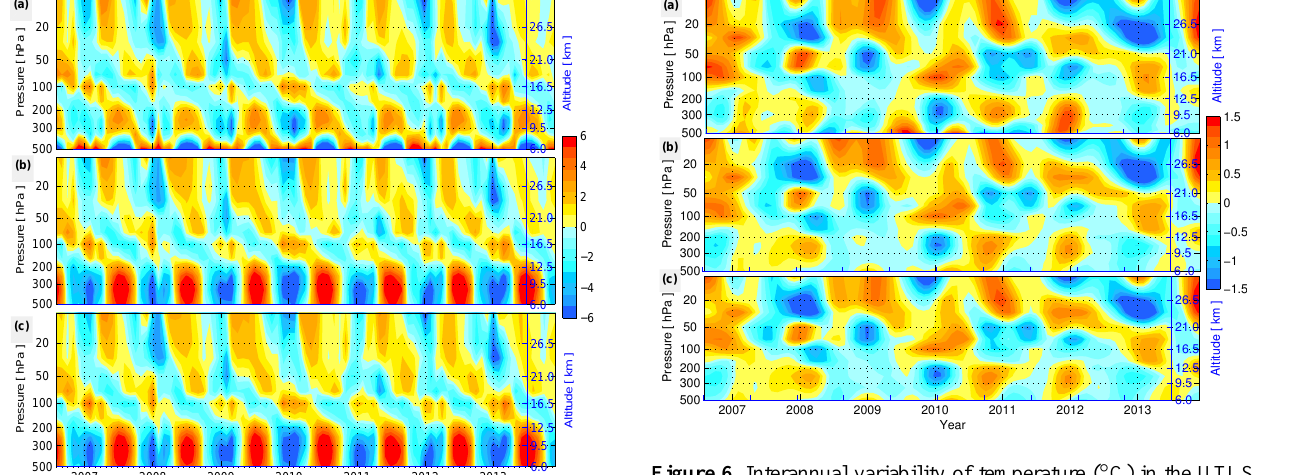
Figure 6. Interannual variability of temperature ( ◦ C) in the UTLS region based on (a) COSMIC RO, (b) MERRA, and (c) ERA- Interim from August 2006 to December 2013. (a) 200 hPa, (b) 100 hPa, (c) 70 hPa, and (d) 50 hPa levels are shown in Fig. 5 to estimate the absolute bias (against COS- MIC RO data) in reanalysis temperature data. Both MERRA and ERA-Interim indicate warm bias at all the levels with varying magnitudes over different seasons. Both reanalysis products are found to be warmer by ∼ 1 ◦ C in June at 200 hPa level (Fig. 5a), ∼ 1 . 5 ◦ C at 100 hPa level (Fig. 5b), and up to 2 ◦ C at 70 hPa level from November to May (Fig.